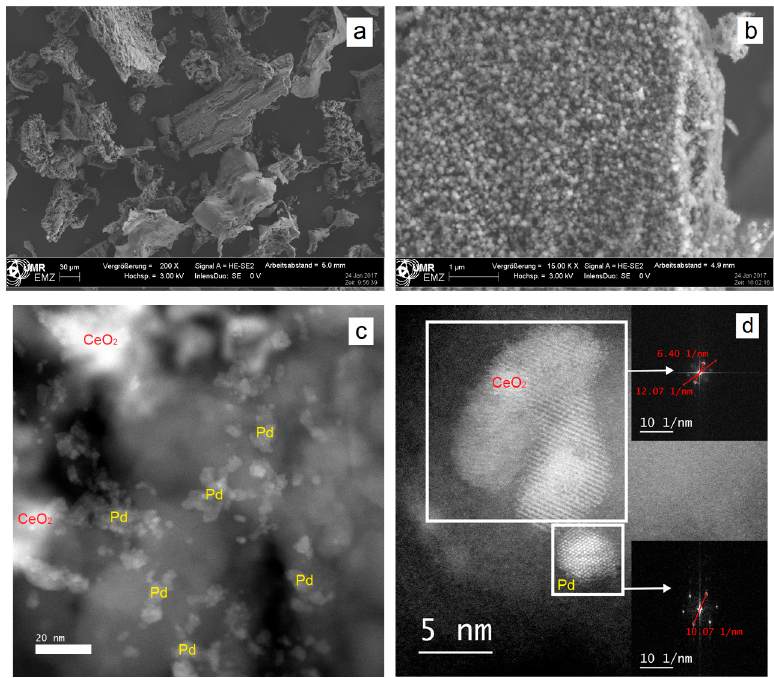
Figure 1. Electron microscopy: ( a , b ) SEM images of RHS; ( c ) TEM image of 0.6Pd/CeO 2 /RHS catalyst; ( d ) SAED analysis of 0.6Pd/CeO 2 /RHS catalyst. Table 1. BET-specific surface area ( S BET ) calculated according to Ref. [28], average pore volume ( V t ) as well as element analysis data.